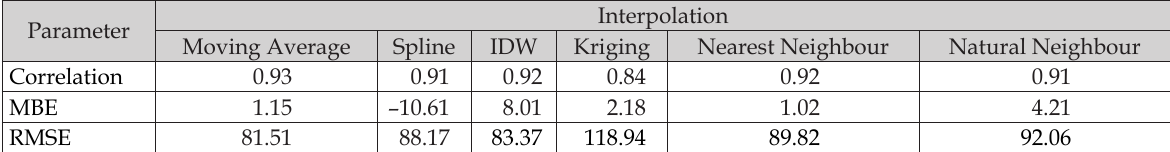
Table 2. Correlation value, Mean Bias Error (MBE), and Root Mean Square Error (RMSE) for several interpolation